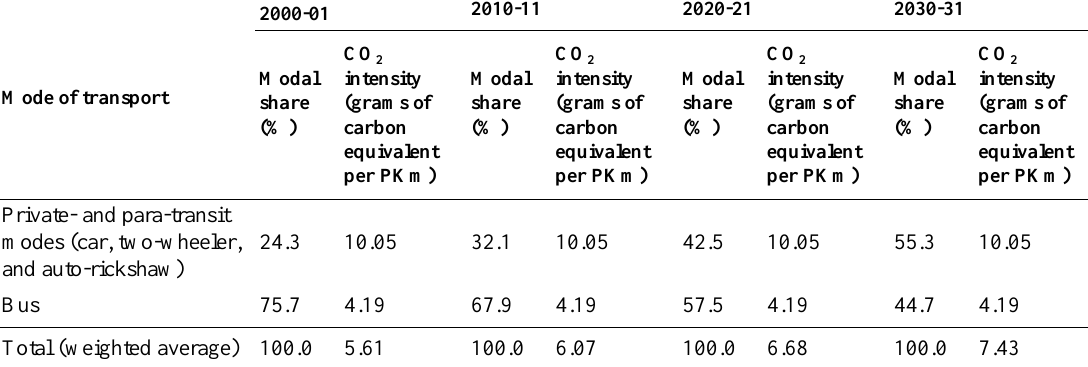
Table 8. Modal share and CO scenario